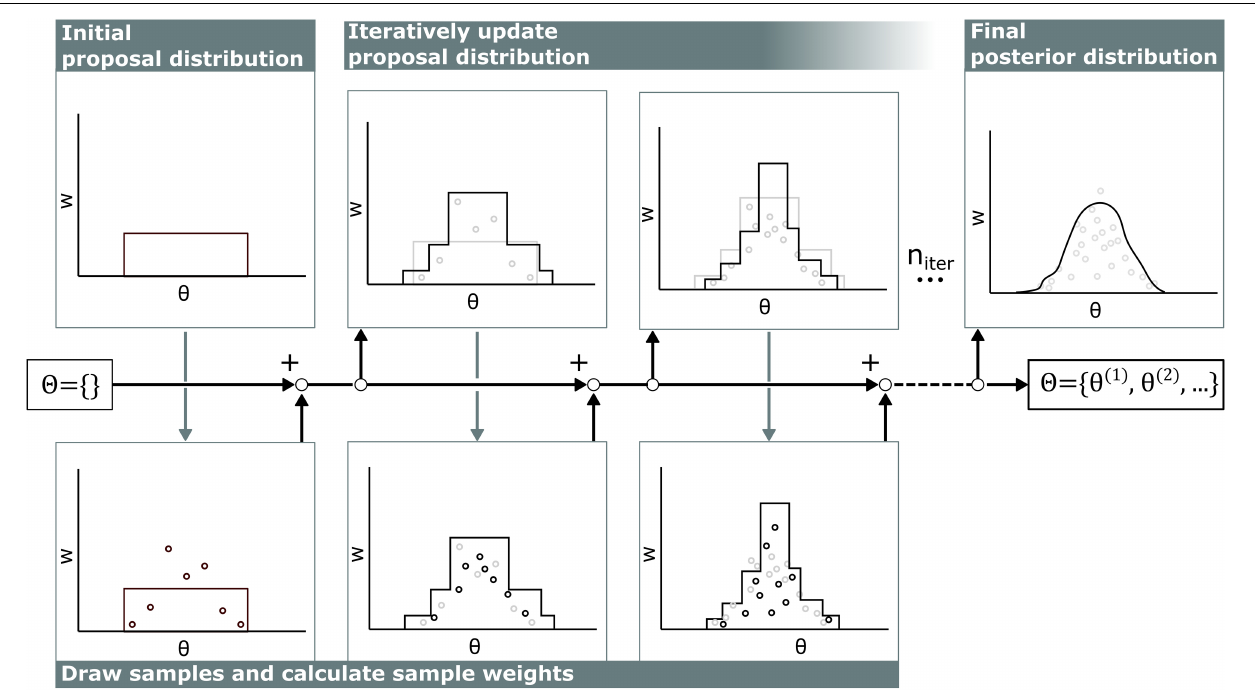
FIGURE 2 | Visualization of adaptive multiple importance sampling. In the first iteration, samples θ are drawn from a uniform distribution and stored in the sample set (cid:50) . For each sample, the corresponding sample weight w is calculated. Then, based on all previous samples θ in the sample set (cid:50) and corresponding sample weight w , the next proposal distribution is defined and new samples are added to the sample set (cid:50) . This iterates n i ter